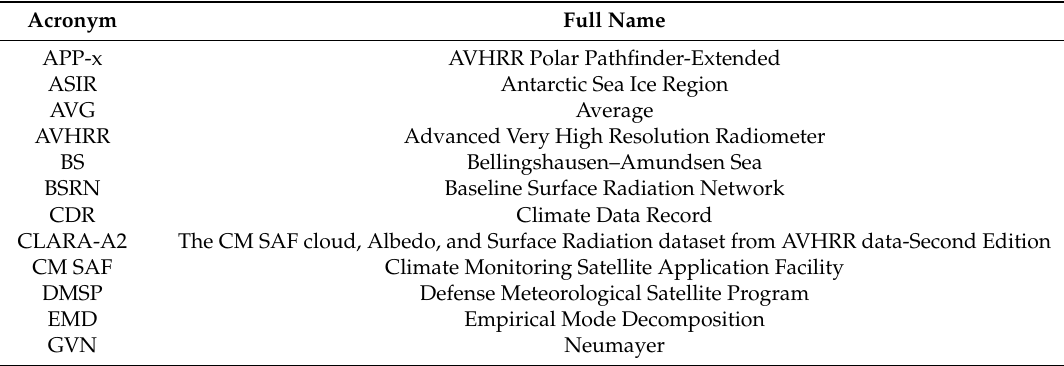
Table 1. List of